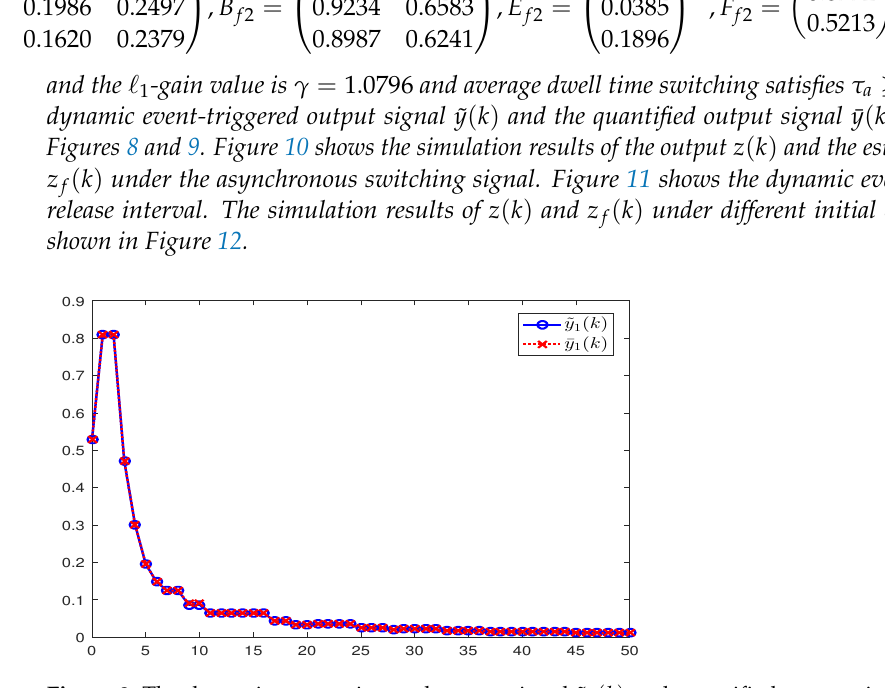
Figure 8. The dynamic event-triggered output signal ˜ y 1 ( k ) and quantified output signal ¯ y 1 ( k ) .